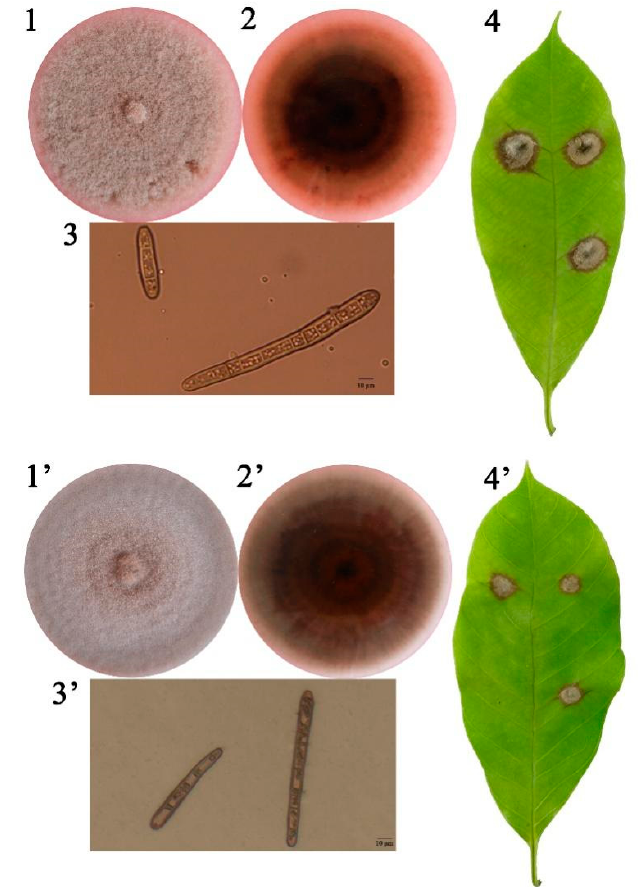
Figure 1. Symptoms of disease caused by Corynespora cassiicola YN49 and CC01 strains in Hevea brasiliensis clone Reyan7-33-97. The ( 1 ) and ( 1 ′ ): mycelium colony on PDA medium (front); ( 2 ) and brasiliensis clone Reyan7-33-97. The ( 1 ) and ( 1 (cid:48) ): mycelium colony on PDA medium (front); ( 2 ) and ( 2 ′ ): mycelium colony on PDA medium (back); ( 3 ) and ( 3 ′ ): optical microscopy view of conidia in ( 2 (cid:48) ): mycelium colony on PDA medium (back); ( 3 ) and ( 3 (cid:48) ): optical microscopy view of conidia in water; ( 4 ) and ( 4 ′ ): CLF symptoms on rubber tree clone Reyan7-33-97. water; ( 4 ) and ( 4 (cid:48) ): CLF symptoms on rubber tree clone